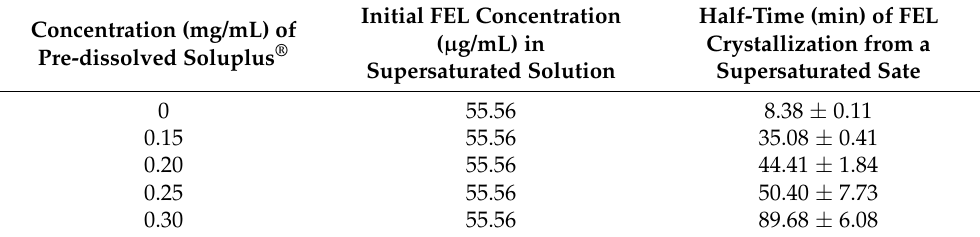
Table 2. Half-time (T 1/2 ) of the recrystallization of crystalline FEL from a supersaturated concentrated solution (55.56 µ g/mL) at 37 ◦ C in the mixed solution of PBS (pH6.8) without/with pre-dissolved Soluplus ® (0.15, 0.2, 0.25 and 0.3